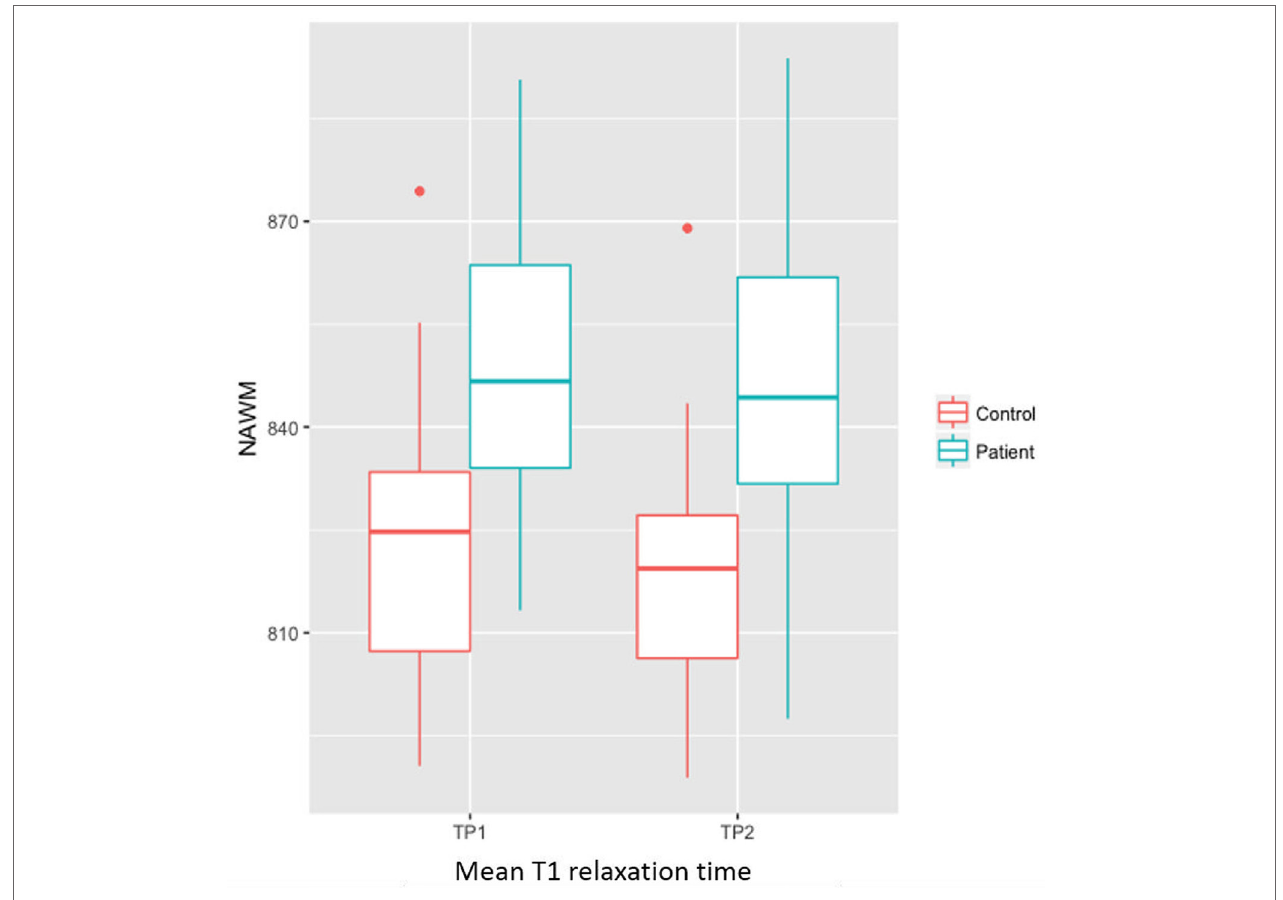
FigUre 2 | Bar plot showing significant higher T1 in NAWM of patients compared to controls at both time-point ( p =